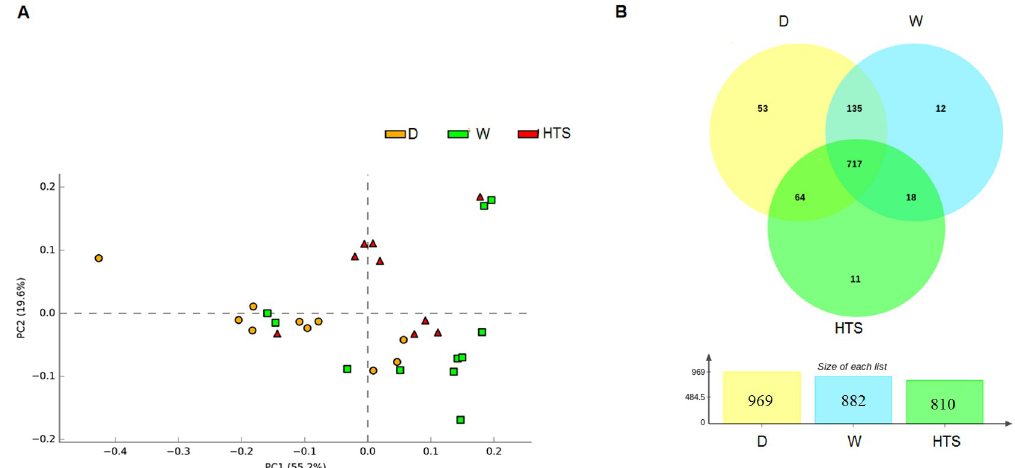
Fig 5. Effect of regimen on community profile of hays (A) PCA loadings plot of viable profile between regimens, notably HTS samples and (B) Venn diagram of the core community, shared and unique OTUs specific to D (n = 10), W (n = 11) and HTS (n = 9) treatments.